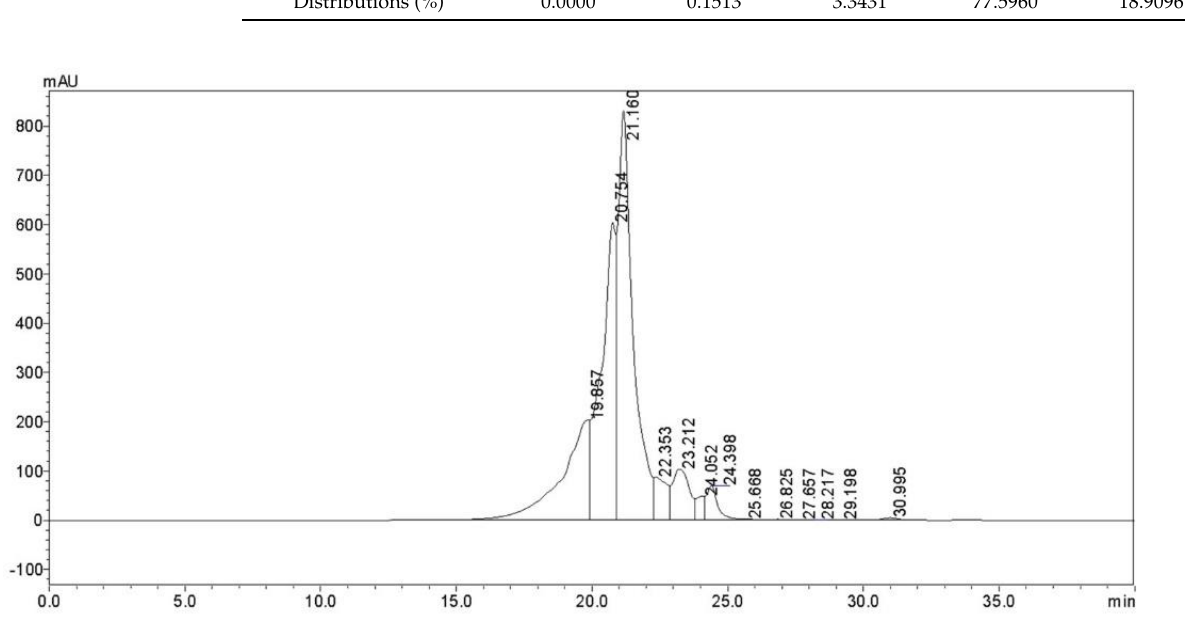
Figure 1. Corn oligopeptide chromatogram (220 nm). Table 3. Molecular weight distributions of corn oligopeptides. Molecular Weight